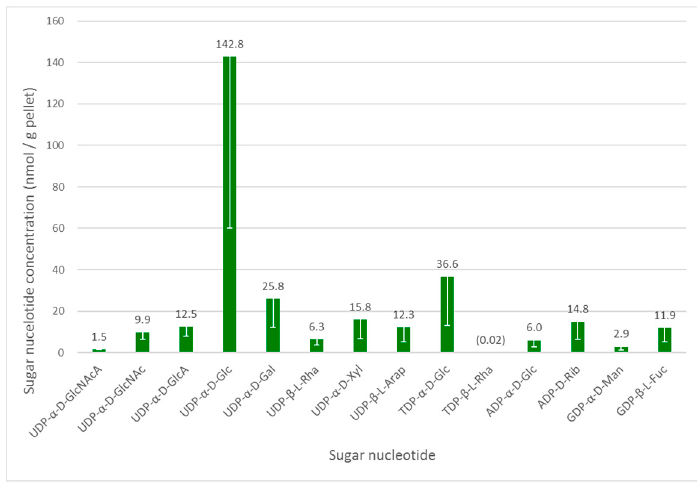
Figure 2. Intracellular sugar nucleotide profile of Euglena gracilis grown under photoheterotrophic conditions. An internal standard UDP- α - D -GlcNAcA (1.46 nmol/g pellet) was added to the samples. The data are mean of three biological replicates; error bars (negative value only) indicate standard error. The identity of all NDP-sugar species was confirmed using authentic standards.